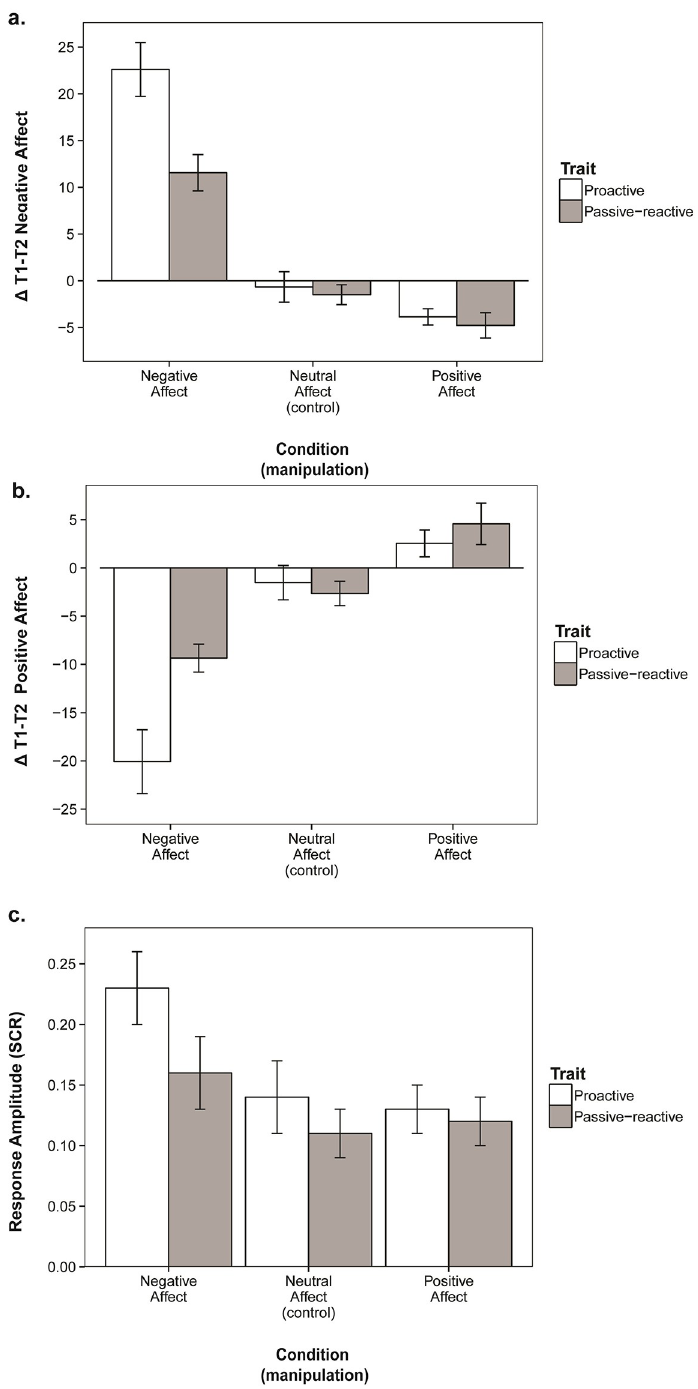
Fig 5. Affective responses to the affect manipulations for trait-proactive and passive-reactive participants. Dependent variables are (a) the increase between T1 and T2 in reported negative affect, (b) the decrease between T1 and T2 in reported positive affect, and (c) skin conductance response magnitude (SCR). Moderated by trait-proactivity (group is based on a mean-split).